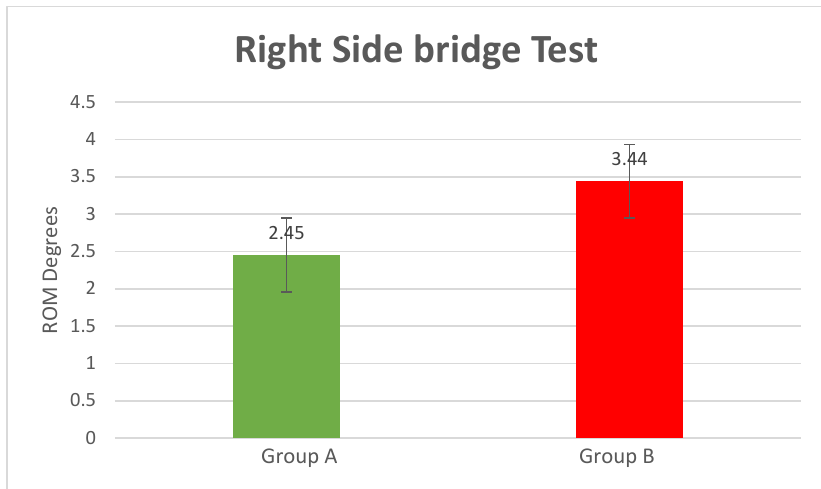
Figure 7. Right-side bridge test results ( p -value = 0.00002).